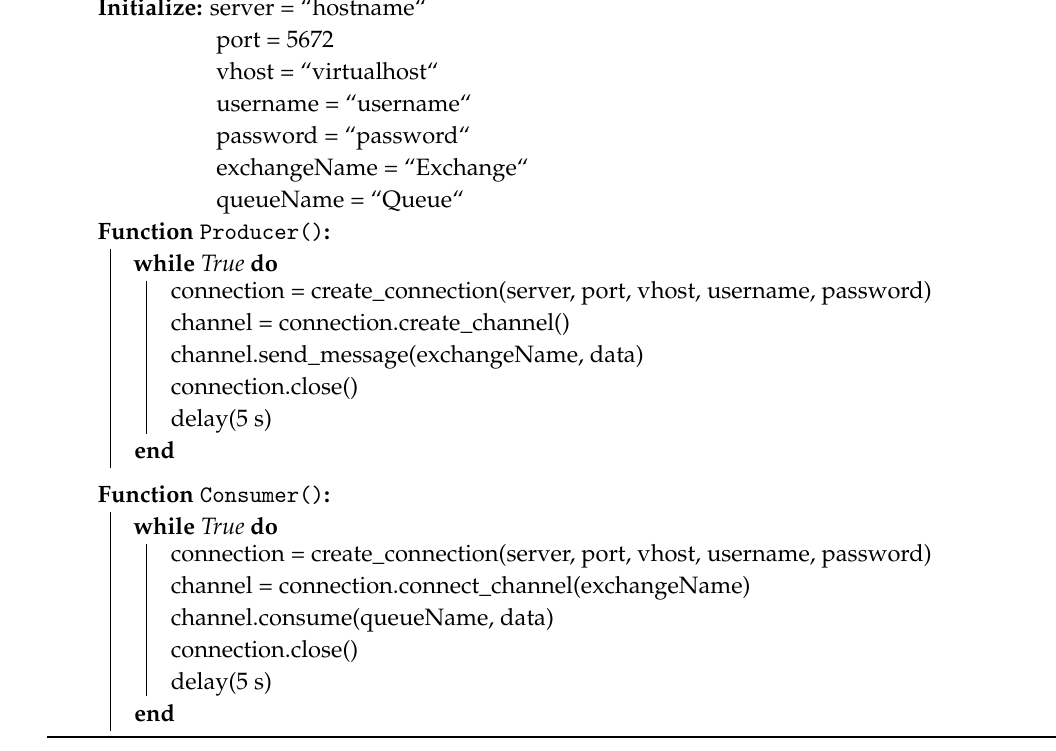
Algorithm 3: Sample code to stream data from Producer to